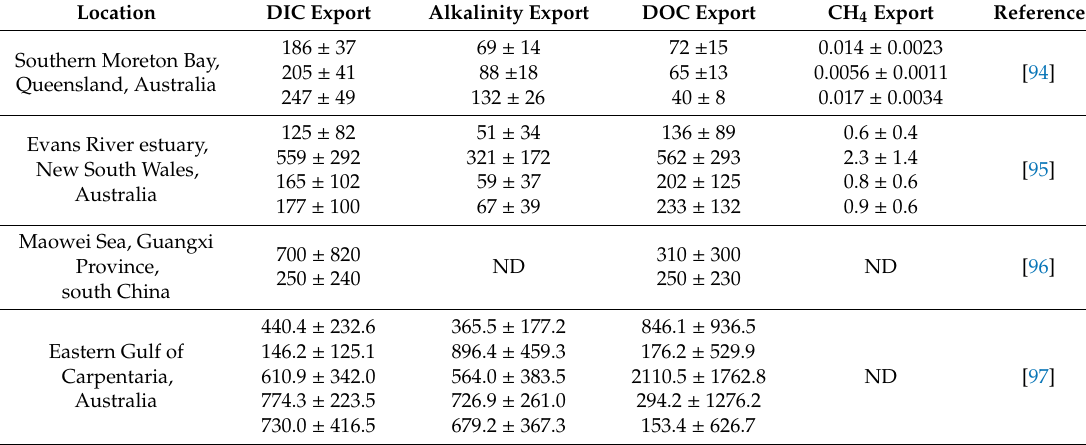
Table 2. Mean ( ± 1 SE) rates (mmol m − 2 d − 1 ) of DIC, total alkalinity, dissolved organic carbon (DOC), and CH 4 export from mangrove forests to adjacent mangrove and coastal waters measured recently from various locations worldwide. These empirical estimates were derived from using a Eularian approach of time-series water sampling and tracing of radium isotopes. ND = no data. Location DIC Export Alkalinity Export DOC Export CH 4 Export